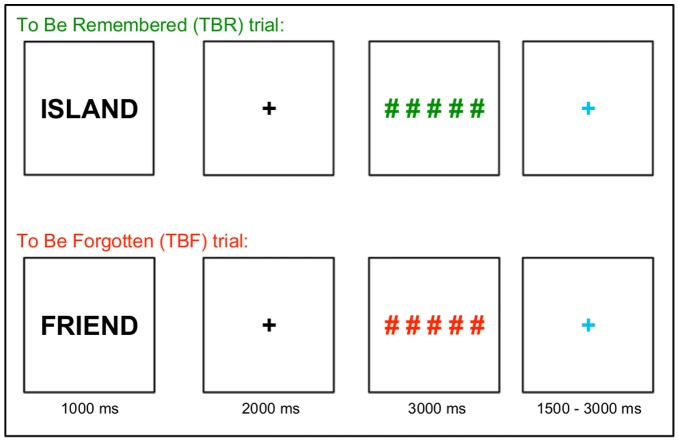
Item method directed forgetting encoding task.Participants were instructed that words associated with green pound/number signs should be remembered for an upcoming memory test, while words associated with red pound/number signs should be forgotten, because they would not be on the test.